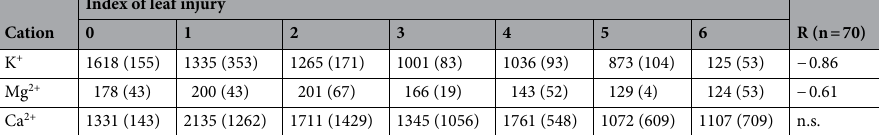
Table 3. Basic cation concentrations in leaves of roadside trees (mg 100 g −1 ). Correlation between cation concentrations and leaf injury index (Spearman correlation coefficient, p < 0.001). Values are median and IQR in parentheses (n = 10 per leaf damage severity).